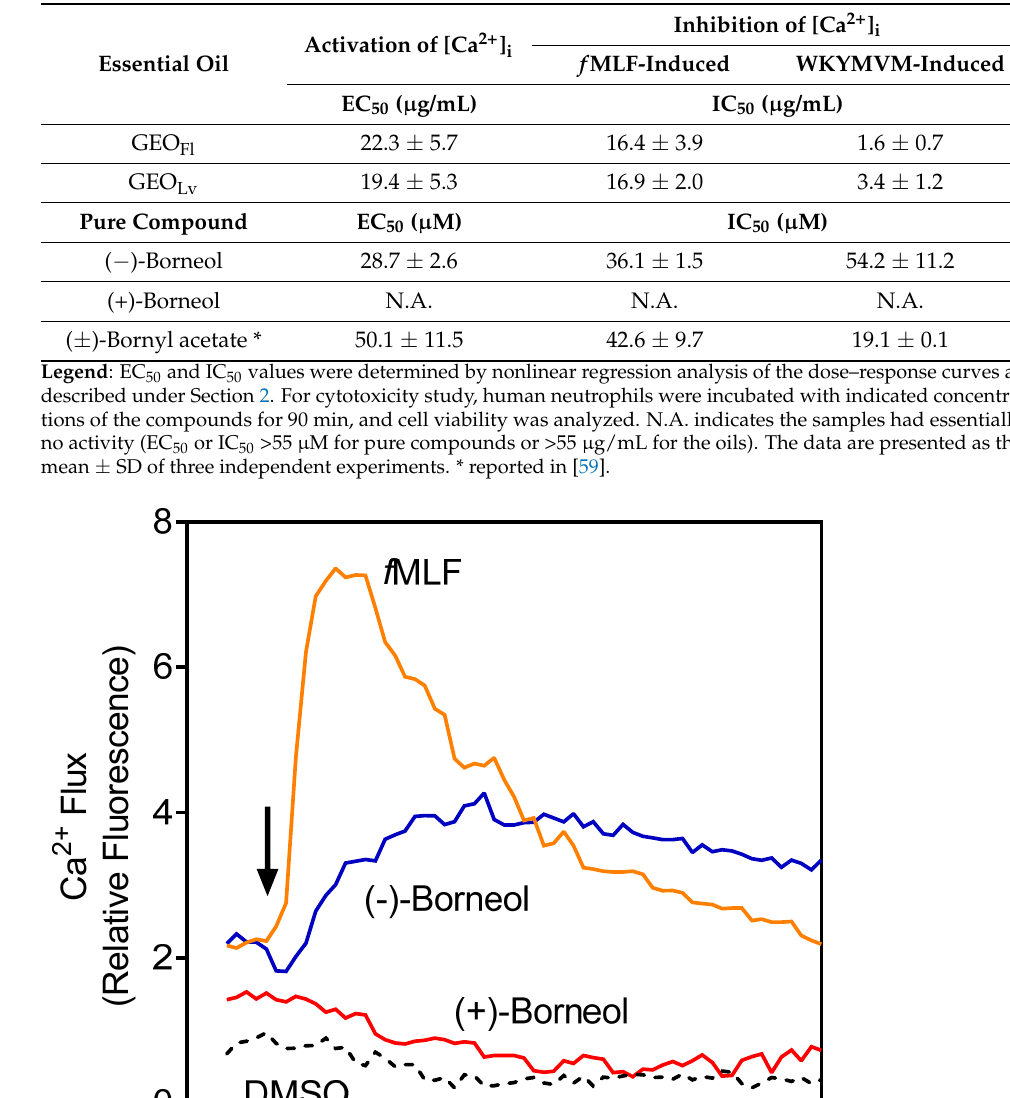
Table 3. Effect of essential oils from G. squarrosa and pure major component compounds on [Ca 2+ ] i , chemotaxis, and cytotoxicity in human neutrophils.